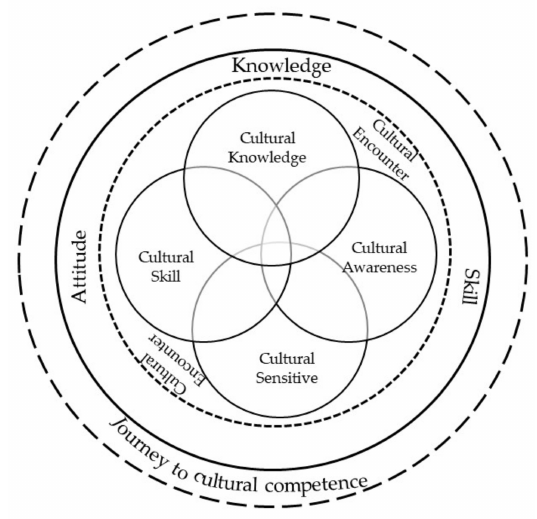
Figure 2. Journey of nursing students to forming cultural